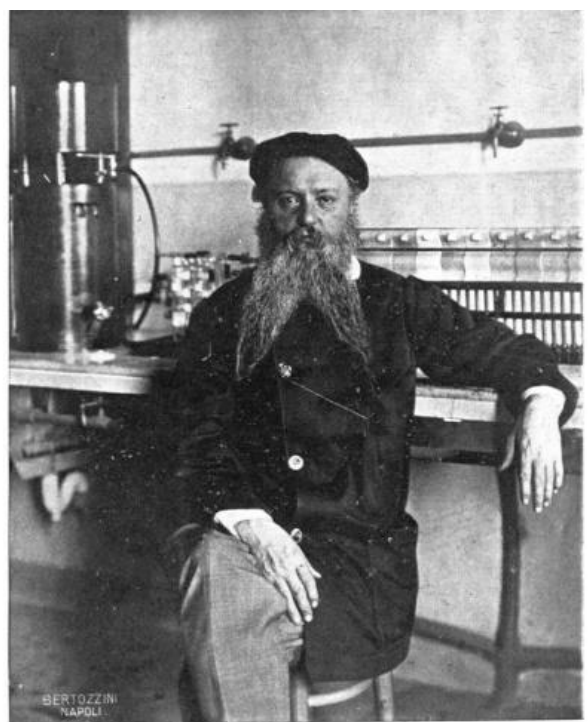
Figure 1. A portrait of Arnaldo Piutti in his laboratory at Naples 9 .